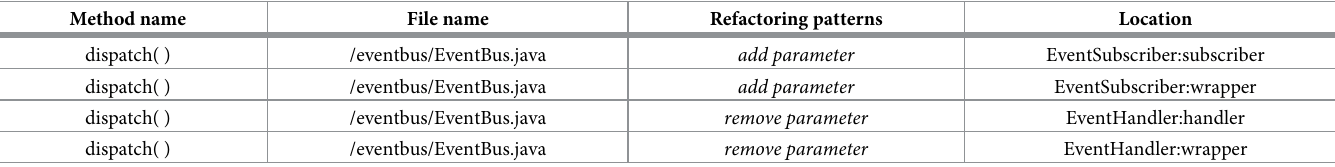
Table 6. Example of inconsistent clone refactoring in